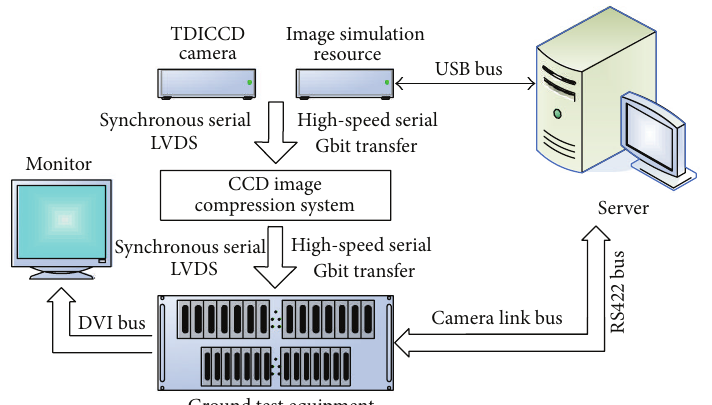
Figure 16: The structure of experiment system.